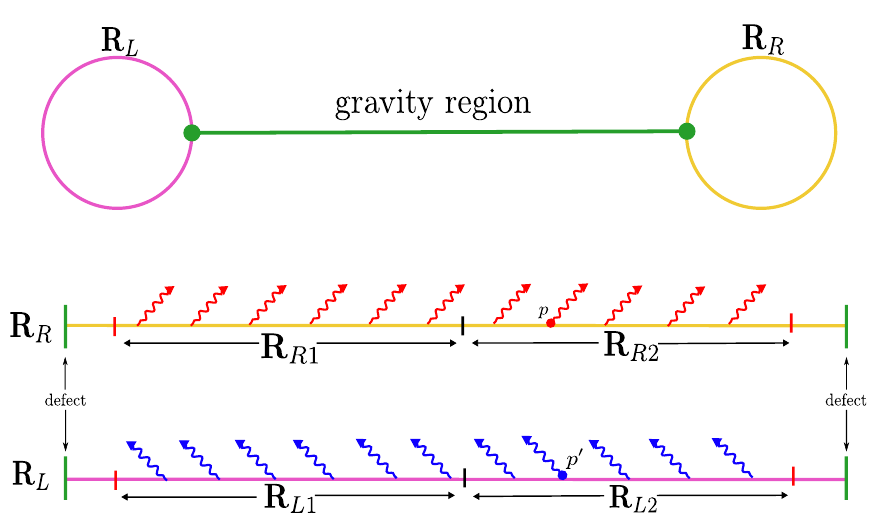
Figure 7 . Picture showing the explanation given in the text. On top, we have a top view of the brane perspective, where the two boundary CFTs on the two cylinders are connected through the brane, shown in green. On the bottom, we unwrap the two CFTs keeping in mind that each respective ends are